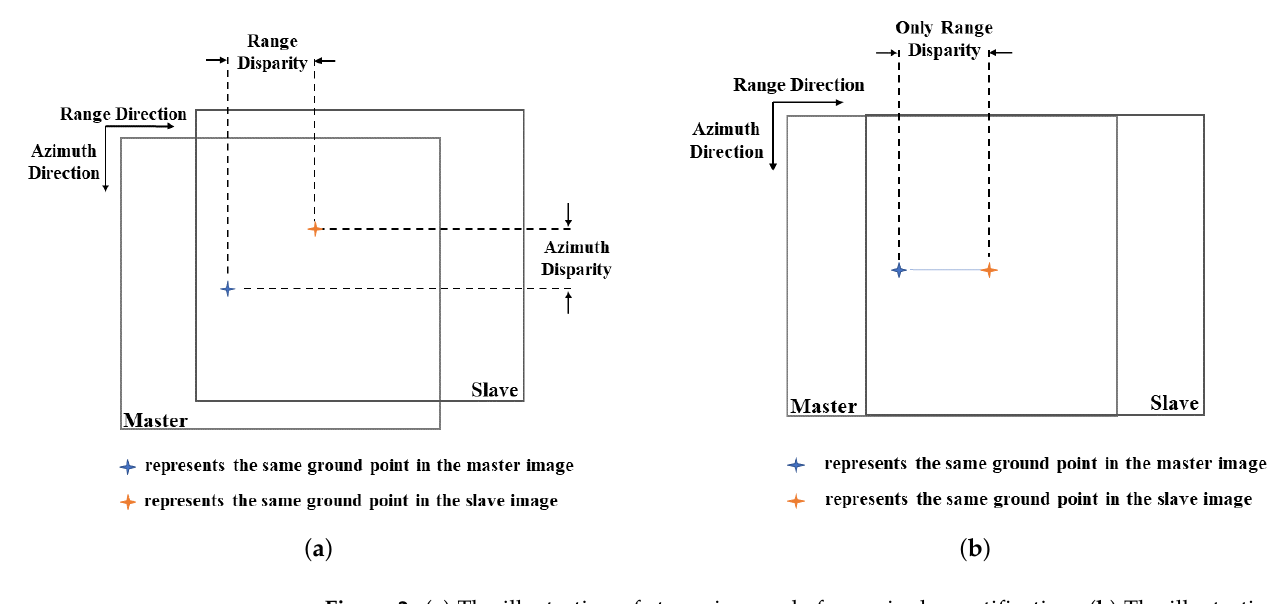
Figure 2. ( a ) The illustration of stereo images before epipolar rectification. ( b ) The illustration of stereo images after epipolar